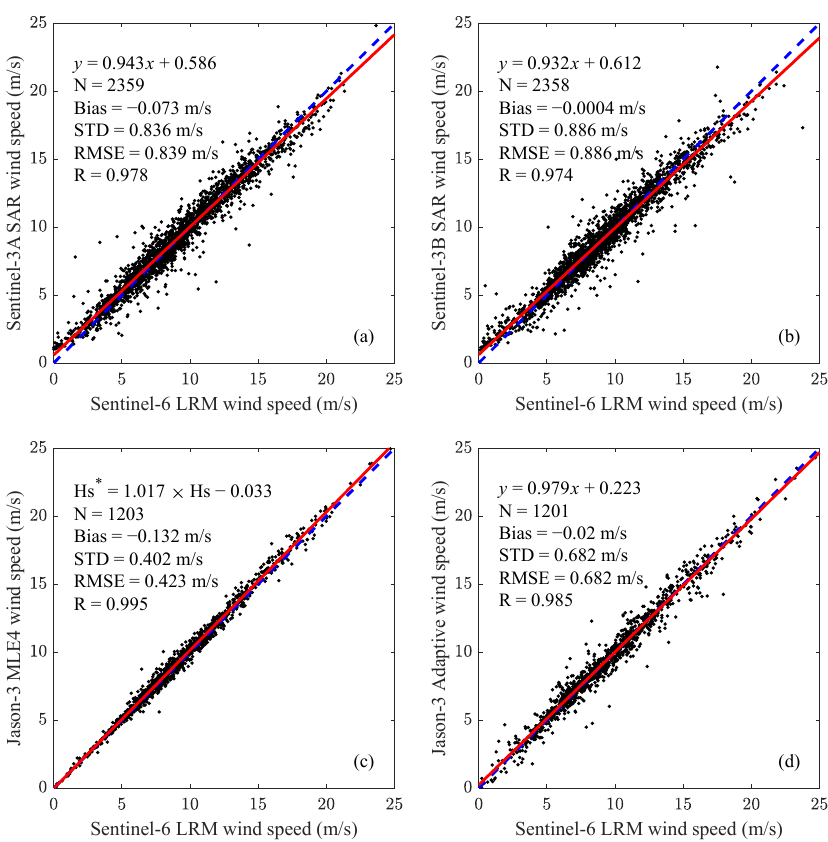
Figure 16. Scatterplots of Sentinel-6 wind speed measurements in LRM against ( a ) Sentinel-3A SARM, ( b ) Sentinel-3B SARM, ( c ) Jason-3 MLE-4 and ( d ) Jason-3 adaptive re-tracking measure- ments.